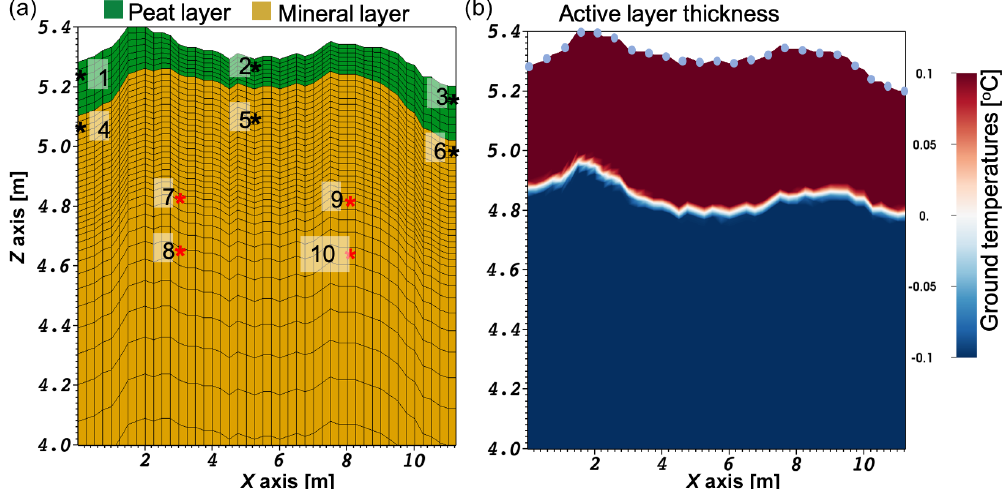
Figure 2. The (vertically exaggerated) 2-D transect used by the ATS model. (a) The unstructured mesh where green represents the peat layer and brown represents the mineral soil layer. Black stars represent the six sensors recording temperature and soil moisture content within the active layer. Red stars represent the four sensors recording temperature and soil moisture content below the active layer. (b) Ground temperature distribution simulated by the ATS model, corresponding to the time of maximum active layer depth. Here the depth of the active layer corresponds to the distance above the white linear feature (i.e., 0 ◦ C) dividing the thawed and frozen regions of the ground. The light blue dots represent the location of the electrodes in this